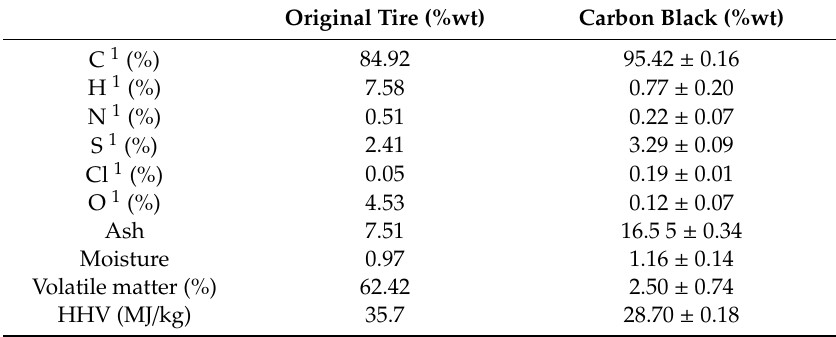
Table 3. Proximate, elemental and heating value analysis for the tire and carbon black.